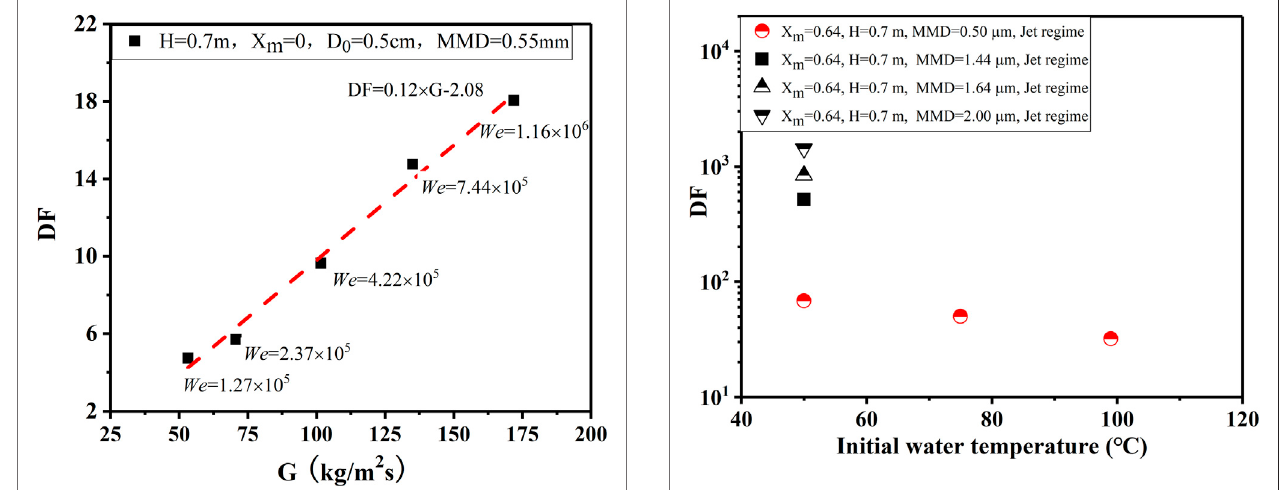
FIGURE 12 | Effect of initial pool temperature and particle diameter on